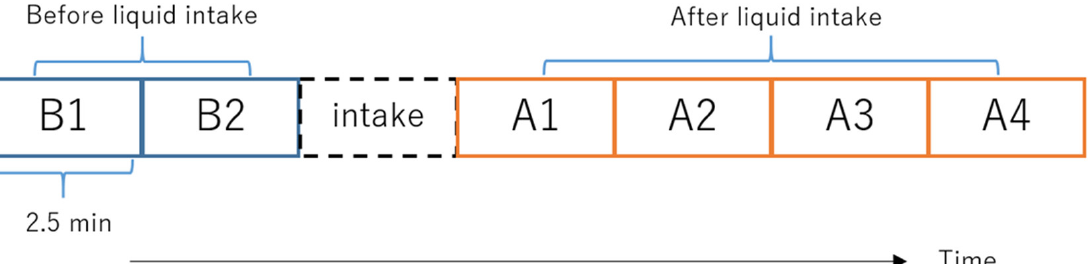
Figure 5. Analysis interval based on a 2.5-min time interval; before liquid intake: B1, B2; after liquid intake: A1, A2, A3, A4.